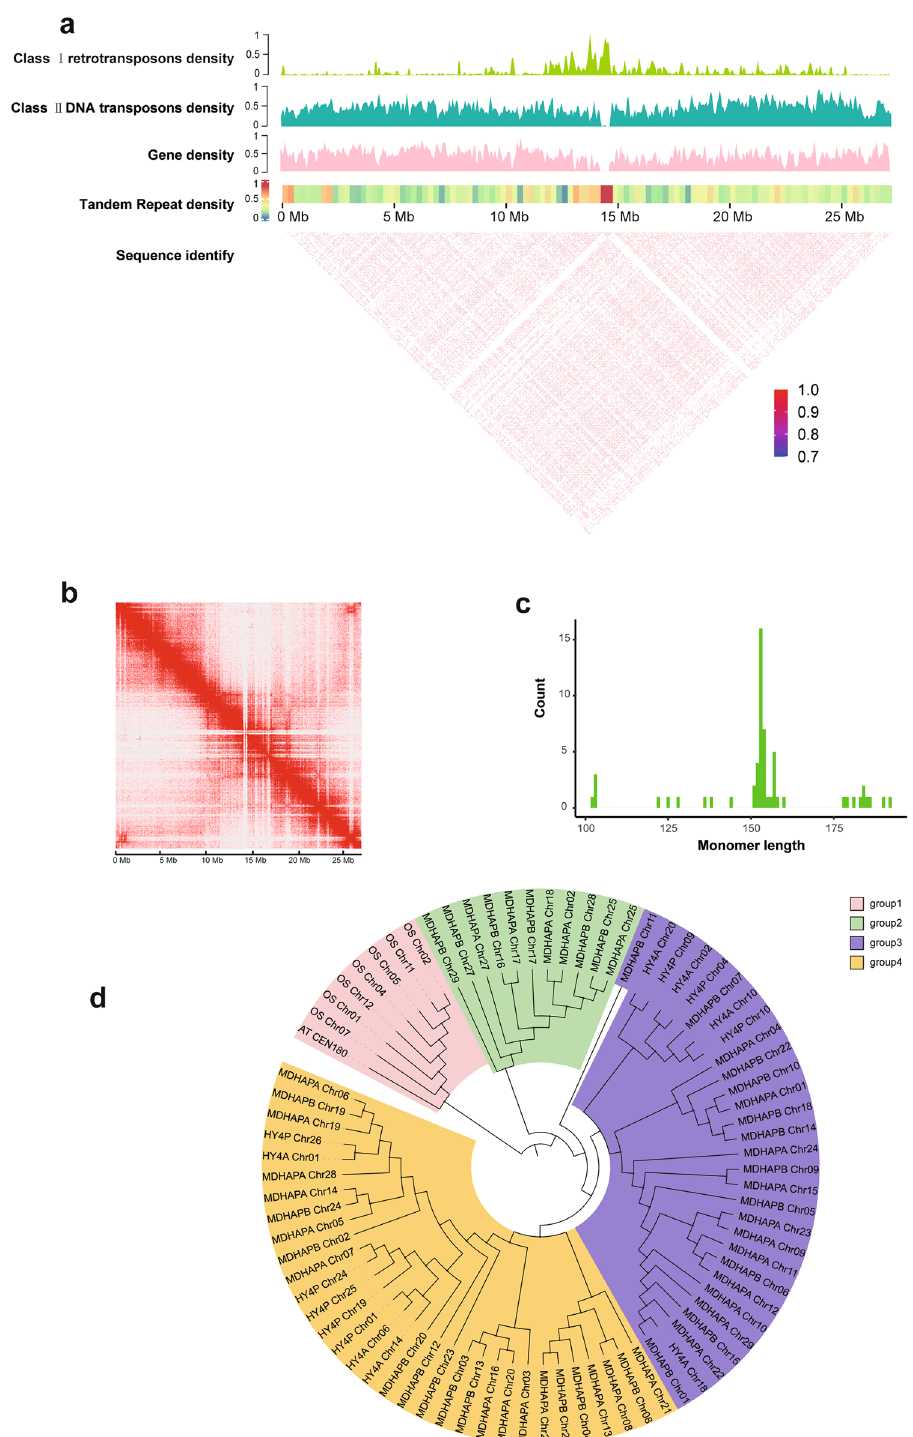
Fig. 3 Characterization of the A.eriantha centromere. a Characterization of the centromere on chr03 of MDHAPB. The heatmap showing pairwise similarity of 50 Kb sequence along the whole chromosome of Chr03. b Heatmap showing Hi C interactions of the chromosome03 of MDHAPB. c The length − distribution of major monomer in A. eriantha . d The phylogenetic tree of centromeric monomers from A. eriantha , A. chinensis , Arabidopsis and